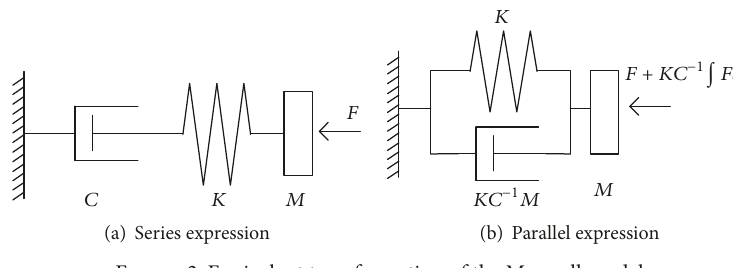
Figure 2: Equivalent transformation of the Maxwell